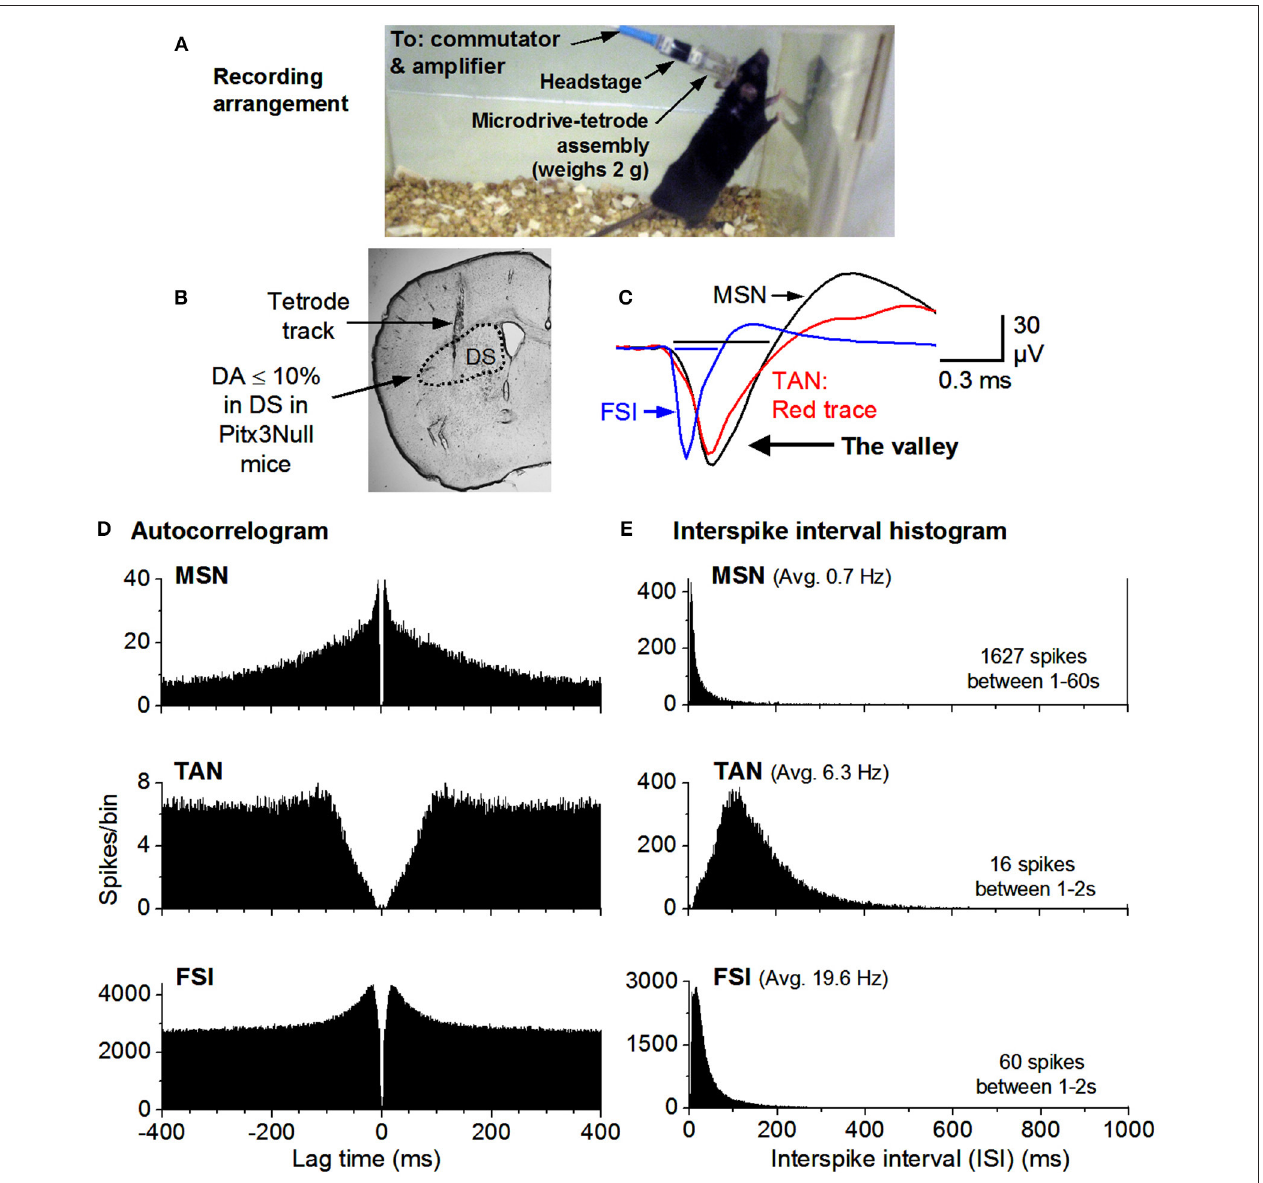
FIGURE 2 | Recording arrangement and identification of MSNs, TANs, FSIs. (A) Recording arrangement. (B) A brain section showing the recording site. (C) FSIs have a short spike waveform ( ≤ 0.25ms for the valley; it is ≥ 0.4ms for MSNs & TANs). (D) Autocorrelograms show that all units have a ≥ 2ms refractory period, expected for individual neurons. The TAN has a longer refractory period because TANs can not fire at high rates. (E) MSN firing is phasic & has a highly skewed ISI histogram. The mean ISI is listed for each example cell. The mean firing rate was 0.7Hz for the MSN, 6.3Hz for the TAN and 20Hz for the